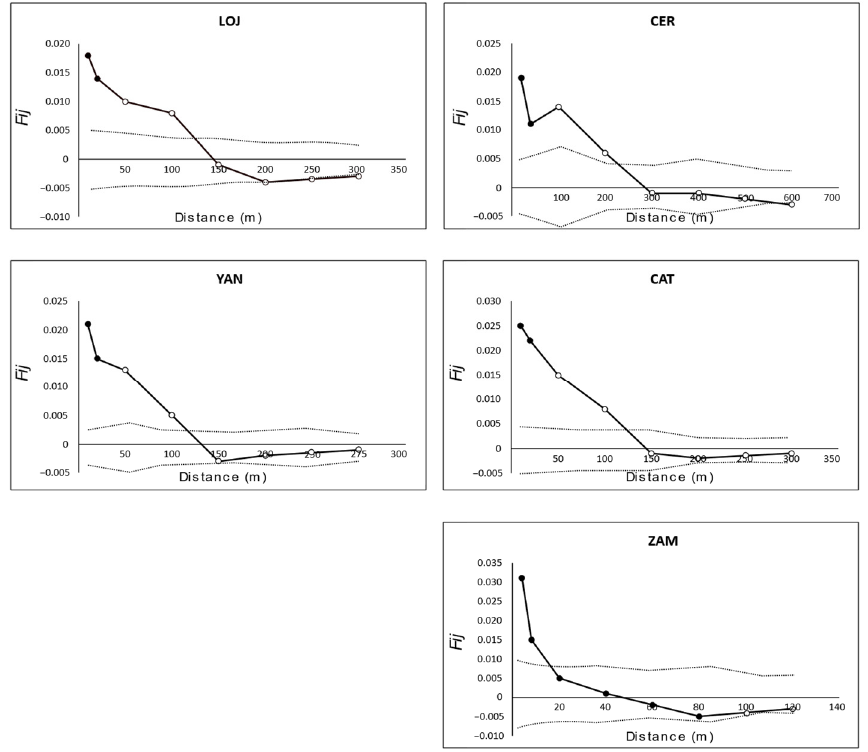
Figure 5. Spatial genetic structure correlograms between the spatial distance and the kinship coefficient ( Fij ) of O. rotundata in the studied populations. Filled circles indicate significant Fij values. Dashed lines indicate 95% confidence intervals per distance class around the null hypothesis of random genetic structure. Population labels refer to Table 2.